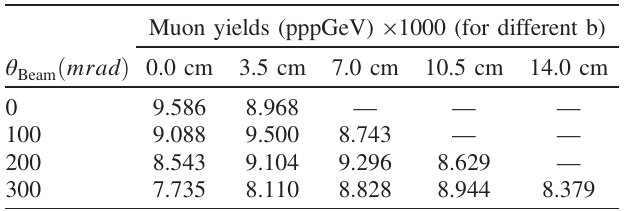
TABLE IV. Muon yields for the NF with different beam-target interaction